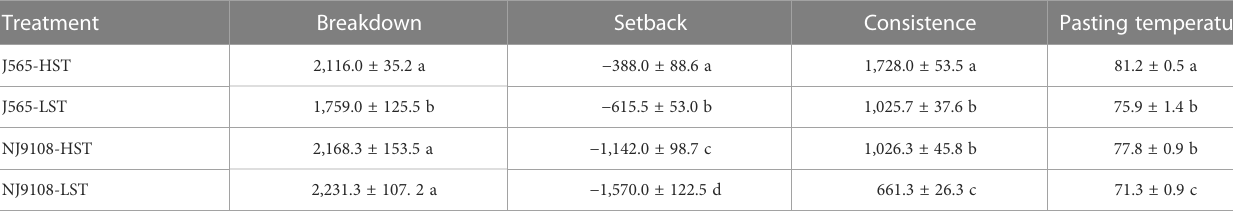
TABLE 2 Difference of rice fl our pasting properties in the two growth seasons.